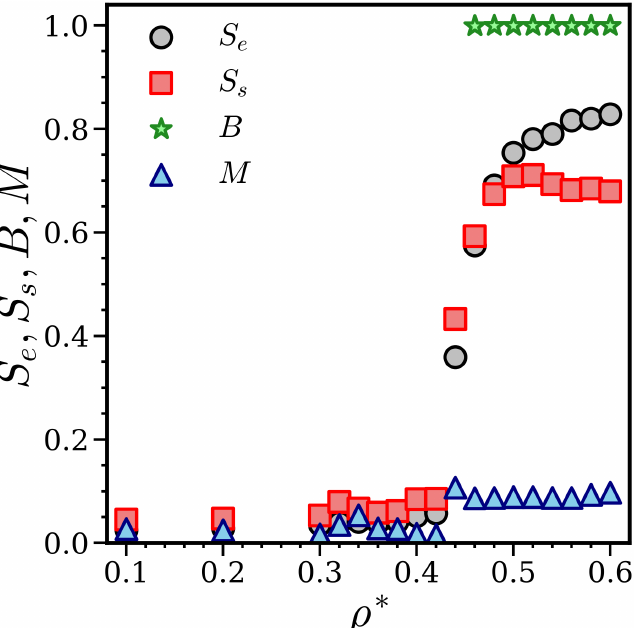
Figure 2. Variation of the nematic order parameters S e and S s of the LCs and DSS, magnetization M , and biaxiality parameter B as a function of density; see